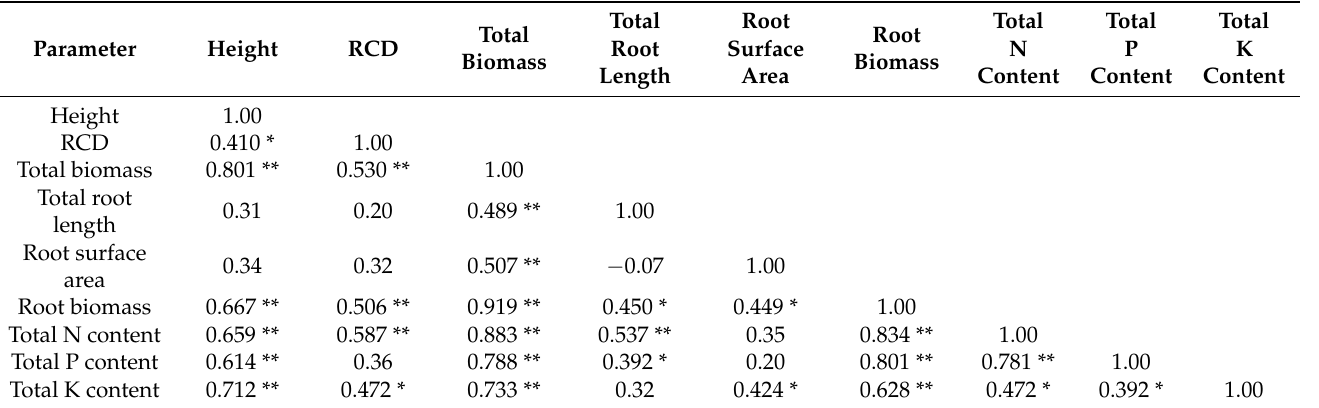
Table 4. Correlation analysis of growth and nutrient